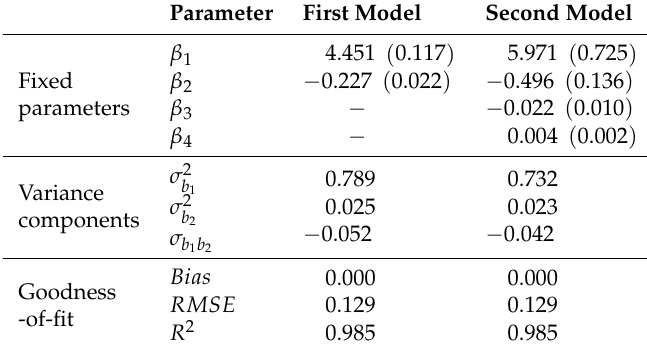
Table 3. Estimated parameters and fit statistics for the proposed mixed effects models. The fixed effects parameter estimates are given by mean (standard error).